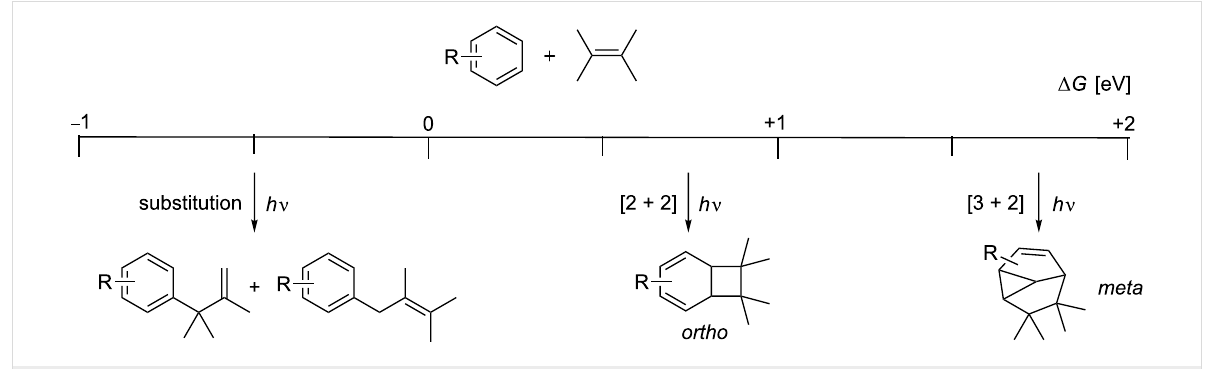
Scheme 3: Mode selectivity with respect of the free enthalpy of the radical ion pair formation.